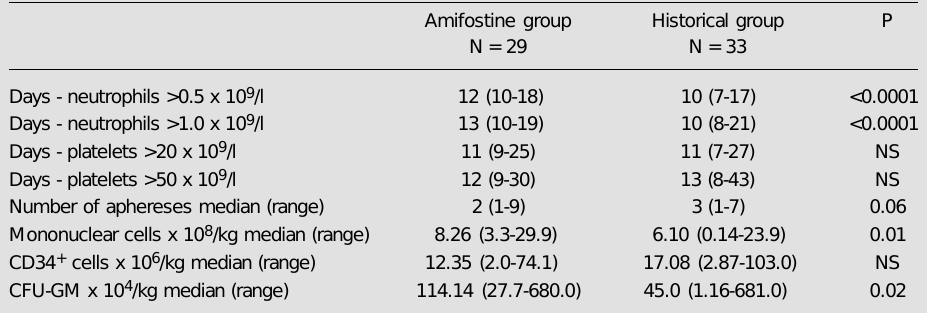
Table 4 - Biological data concerning the mobilization procedure using HDCY plus G-CSF in the amifostine- protected group and a historical non-protected group. Data are reported as median (range) and were analyzed by the Mann-Whitney test. NS,